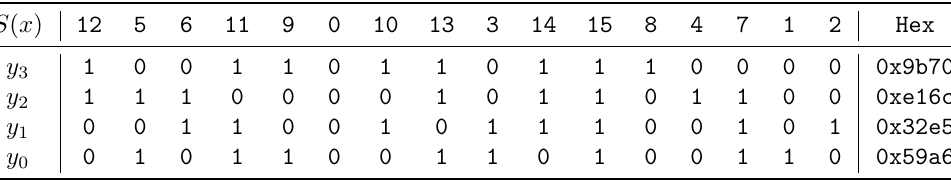
Table 1: Bit-sliced representation of the PRESENT Sbox S : x ∈ GF(2 4 ) → ( y 3 , y 2 , y 1 , y 0 ) ∈ (GF(2)) 4 used in our